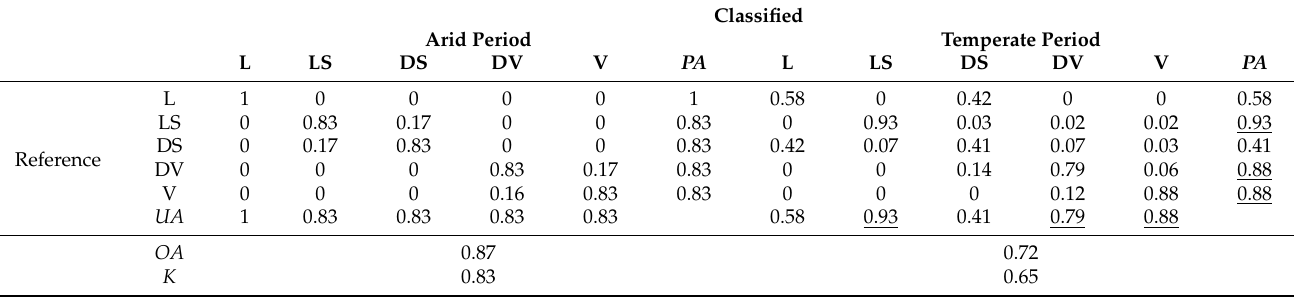
Table 5. Normalized error matrix of the NN classification. When the achieved normalized accuracy is higher than that achieved by the RF classifier, its value is